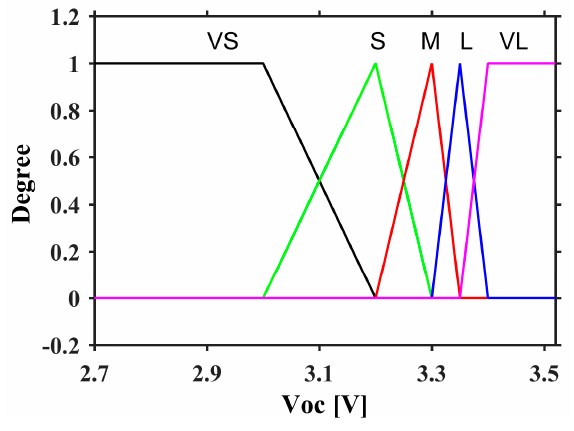
Figure 7. Membership functions of open circuit voltages (OCVs).